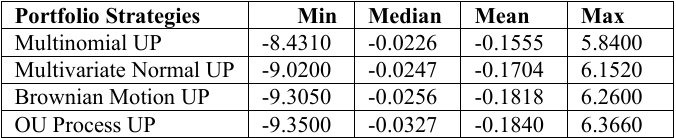
Table 3. Middle term duration data analysis (8 years duration).